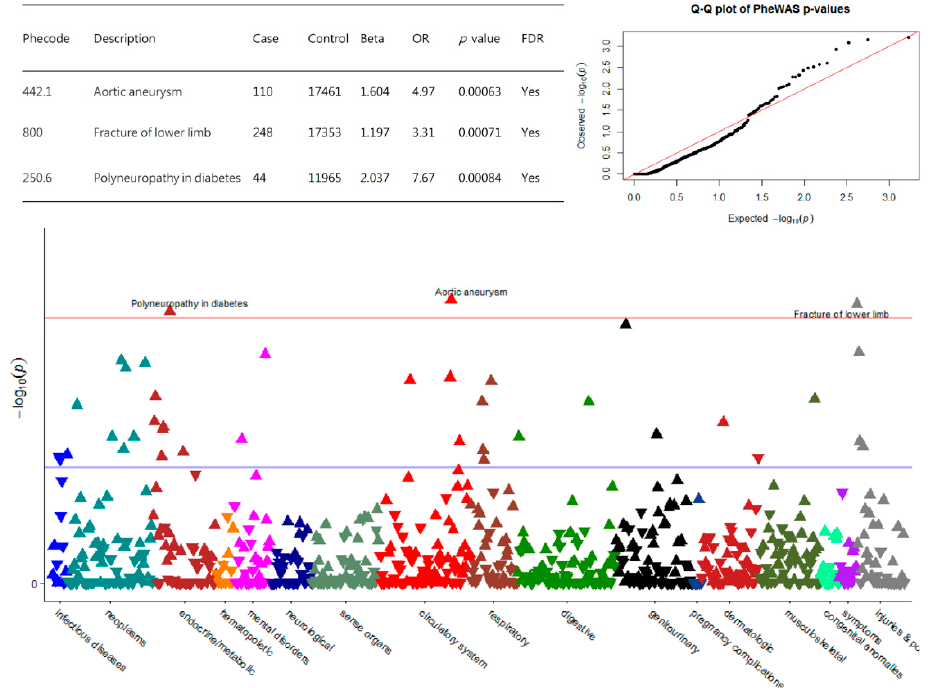
Figure 2. The Manhattan and Q-Q plots of association between KCNQ4 c.546C>G and disease outcomes among 32,728 participants from the study